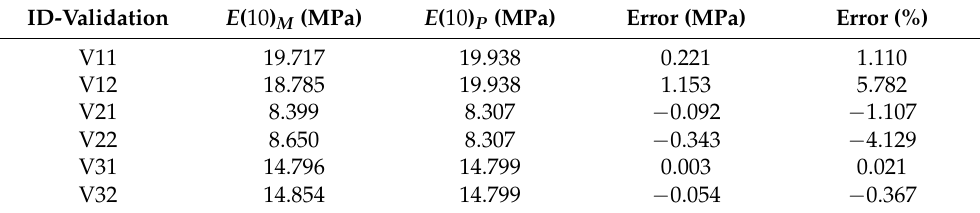
and ( E ( 10 ) for specimens in the validation set. M P